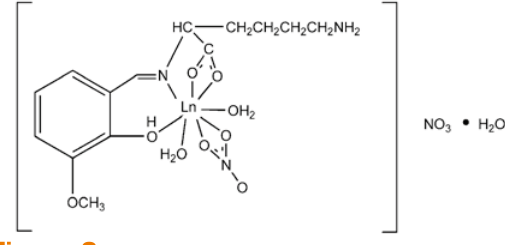
Figure 2. The suggested structure of the complexes.